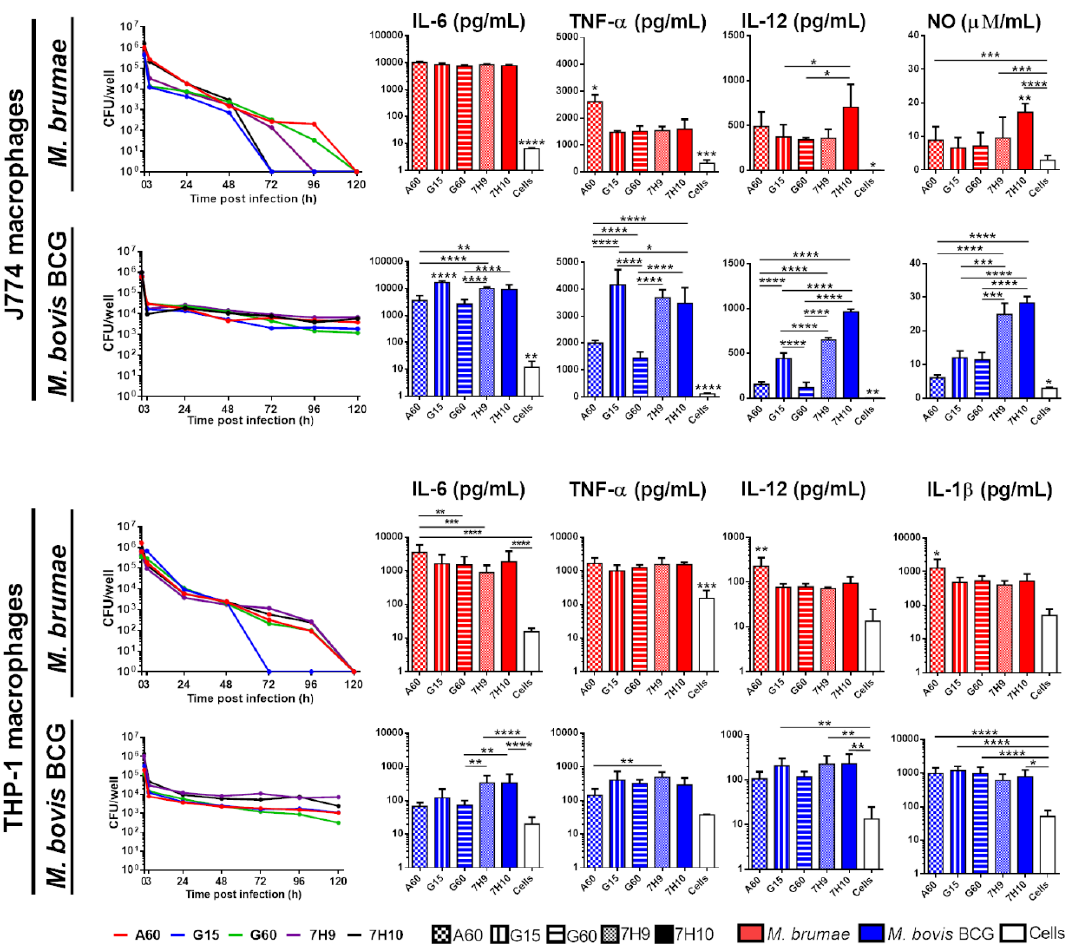
Figure 4. Mycobacterial survival rates and cytokine production triggered by macrophages infected with M. brumae or M. bovis BCG grown on different culture media. Mycobacteria-infected J774 and THP-1 macrophages were lysed at different time points after infection, and mycobacterial colony forming units (CFUs) inside macrophages were counted. Graphs show the mycobacterial burden at different time points. Cytokine production and NO was evaluated in culture supernatants collected 72 h (NO, IL-12, and TNF-a) and 96 h (IL-1β and IL-6) after mycobacterial infection using commercially available ELISA tests. M. brumae in red and M. bovis BCG in blue. Data represent the mean ± SD from three independent experiments. * p < 0.05; ** p < 0.01; *** p < 0.001; ****, p < 0.0001 (ANOVA test).